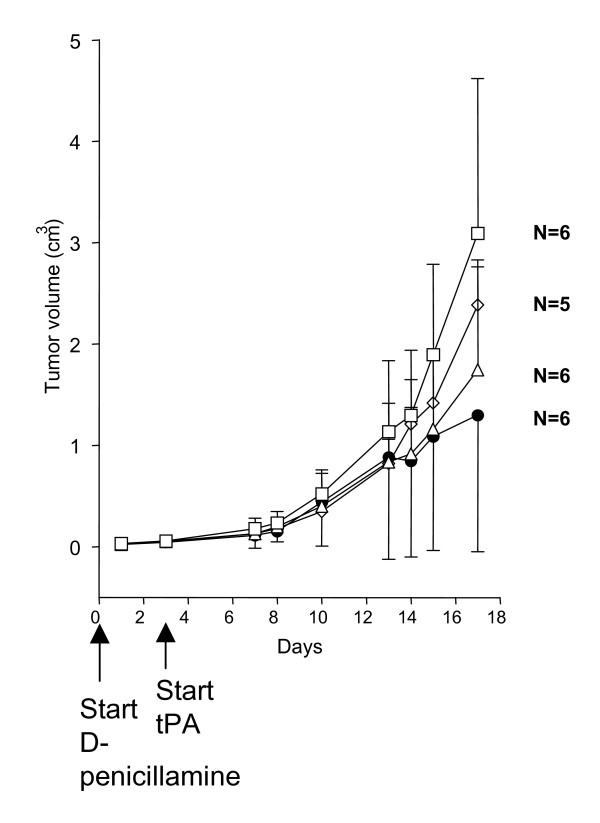
Anti-tumor effects of tPA and D-penicillamine in a human melanoma xenograft model. Nude mice xenografted with human melanoma BLM were treated with tPA, D-penicillamine, or a combination of tPA and D-penicillamine. Shown are mean tumor volumes of at least 5 mice/treatment modality plus/minus SD. A reduction in tumor growth of 58% was observed by applying the combination treatment schedule. Treatment schedules:  : none;  : D-penicillamine;  : tPA; : tPA and D-penicillamine